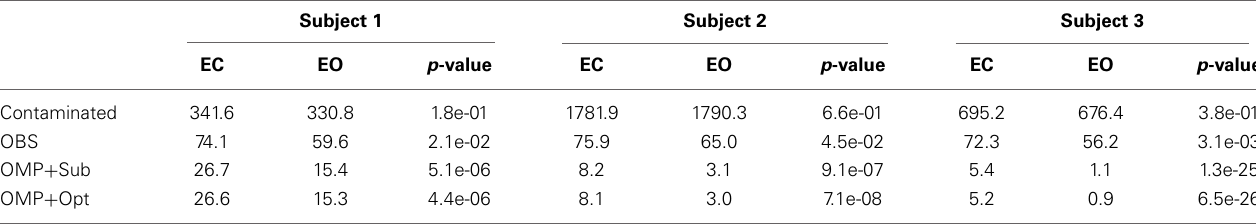
Table 1 | Statistical results of one occipital channel from 3 subjects.